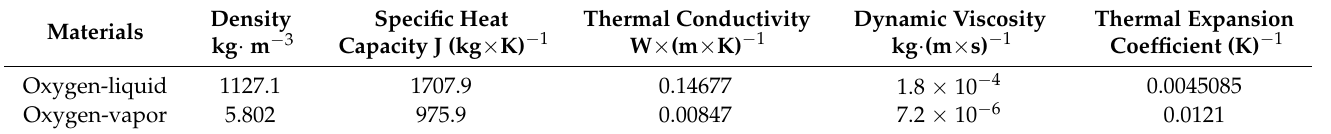
Table 2. Initial thermophysical properties of the saturated